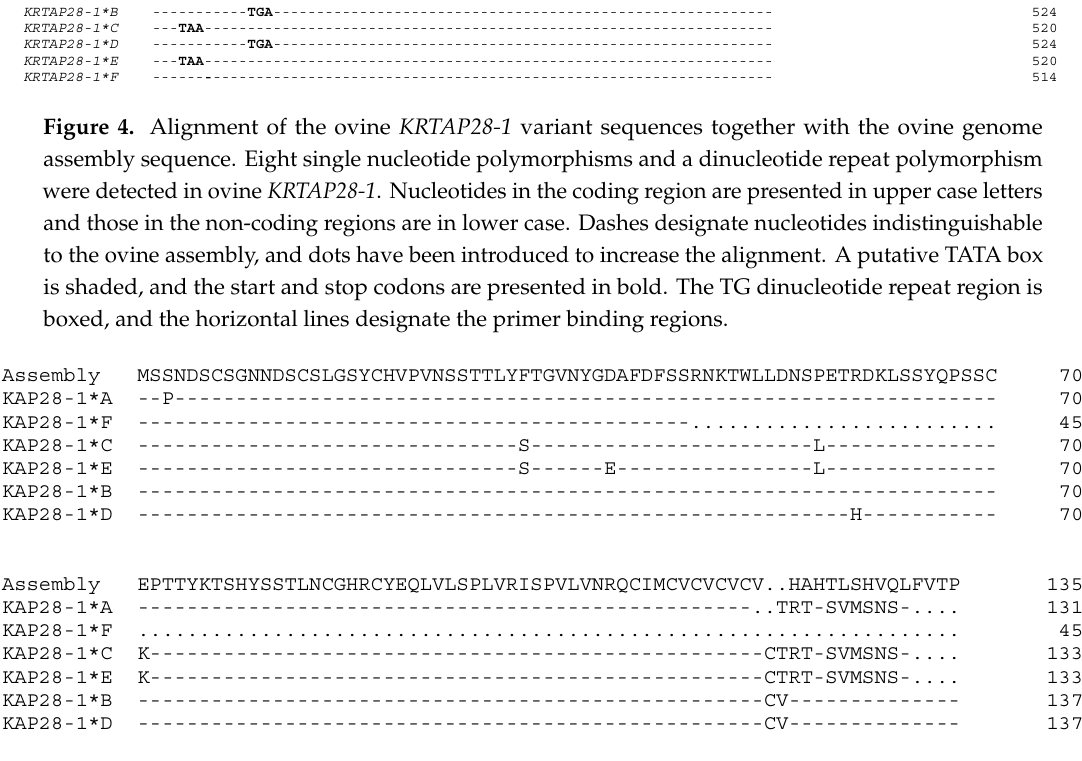
Figure 5. Predicted amino acid sequence alignment of the ovine KRTAP28-1 variants, together with the ovine genome-derived assembly. Dashes signify amino acids identical to the assembly sequence, and dots have been introduced to increase the alignment.